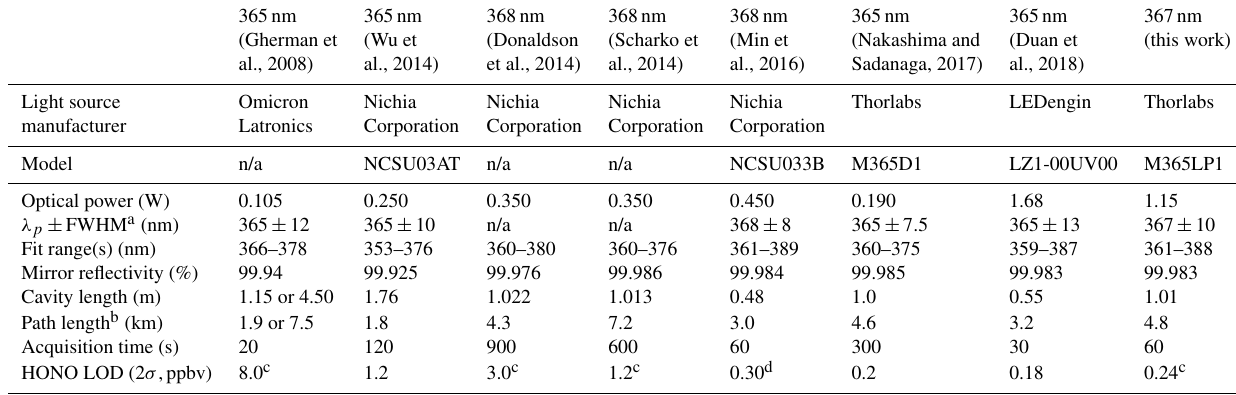
Table 1. State-of-the-art IBBCEAS instruments for quantification of NO 2 and HONO in the near-UV region.